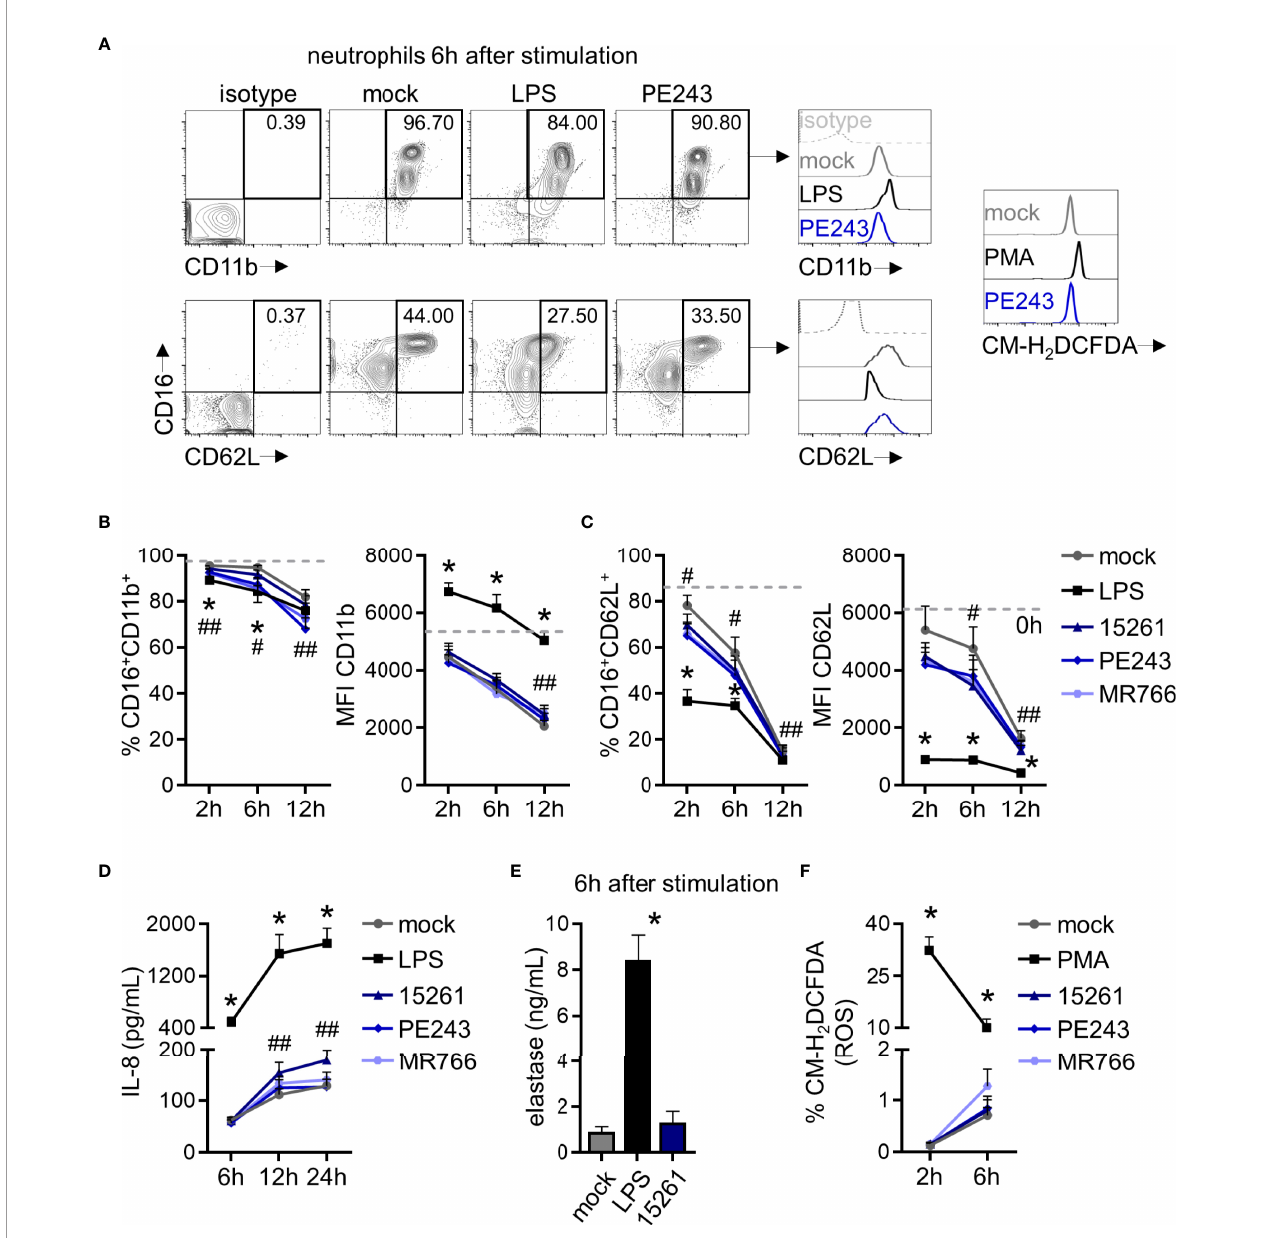
FIGURE 2 | ZIKV mildly modulates CD62L expression in human neutrophils but does not stimulate the production of cytokines, elastase, and reactive oxygen species by these cells. (A) Contour plots depicting the frequency of neutrophils CD16 + CD11b + and CD16 + CD62L + and the fl uorescence intensity of CD11b and CD62L molecules inside these populations at 6 hours after stimulation with mock, LPS (100 ng/mL), or ZIKV PE243 (1 MOI). This time point and strain were selected as a representative of these results. Isotype control antibodies were employed as a negative fl uorescence control to set the gates. A representative result of chloromethyl-H 2 DCFDA (CM- H 2 DCFDA) fl uorescence in the total neutrophil population at 6 hours after stimulation with mock, PMA (16 nM), or ZIKV PE243 is also shown. (B) Frequency of neutrophils CD16 + CD11b + and the mean fl uorescence intensity (MFI) of CD11b in that population at 2, 6, and 12 hours after stimulation with mock, LPS, or ZIKV strains (1 MOI). The dashed line represents the measurements right after neutrophil isolation from blood (time 0). (C) Same analysis as in (B) was applied to the CD62L molecule. (D) IL-8 levels in neutrophil culture supernatant at 6 and 12 hours after stimulation. (E) Elastase levels in neutrophil culture supernatant at 6 hours after stimulation. (F) Frequency of neutrophils CM-H 2 DCFDA + at 2 and 6 hours after stimulation. Bars indicate SEM. Two-three independent experiments are shown (n = 6 – 12). The asterisk (*) denotes the statistical difference between mock and LPS or PMA, and the number sign (#) represents the difference between mock and all the three ZIKV strains at that time point. Double number signs (##) denote the statistical difference between mock, ZIKV PE243, and ZIKV MR766 (B - %CD16 + CD11b + ); between mock, ZIKV 15261, and ZIKV MR766 (B - MFI CD11b); between mock and PE243 (C - %CD16 + CD62L + ); between mock, ZIKV 15261, and ZIKV PE243 (C - MFI CD62L); between mock and ZIKV 15261